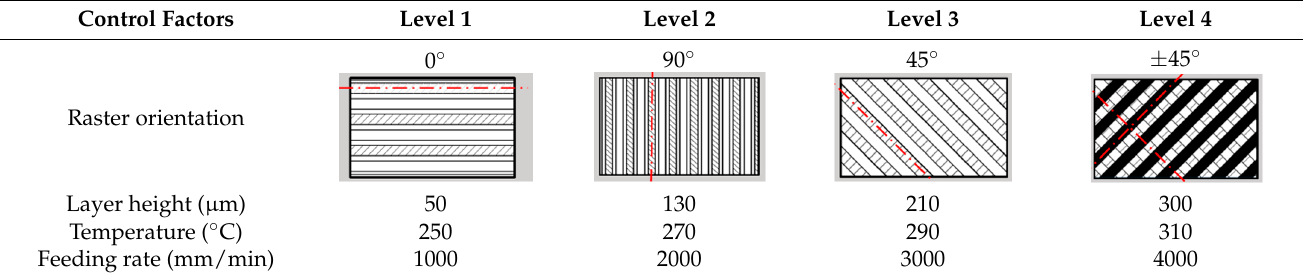
Table 2. Control factors used in the experimental procedures with their assigned levels.